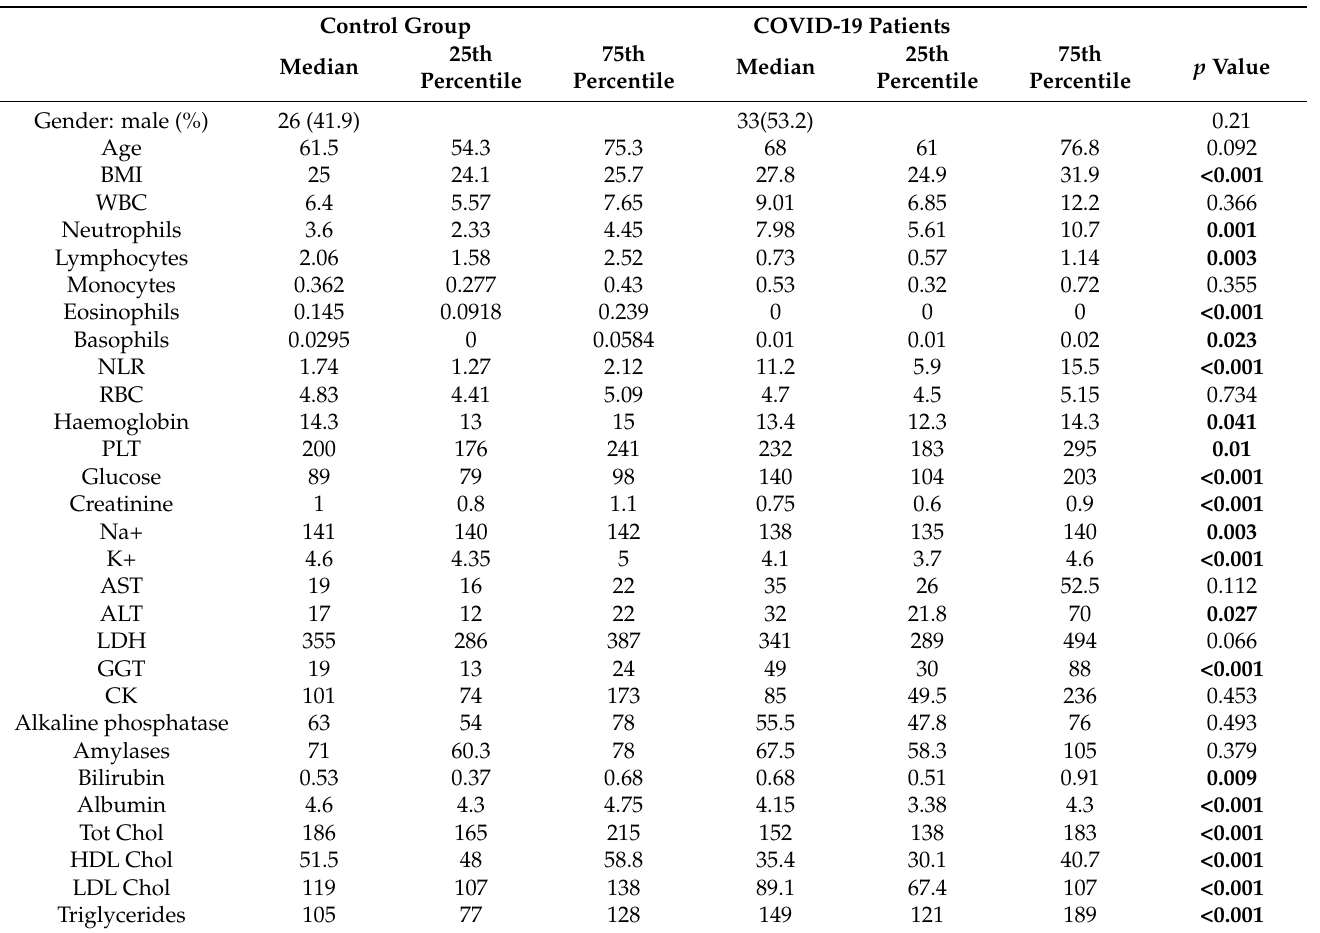
Table 4. Comparison of main biochemical parameters in COVID-19 patients vs. control group. Data are expressed as median value and interquartile range (IQR) or as absolute number and percentage. Bold indicates statical relevant data. Control Group COVID-19